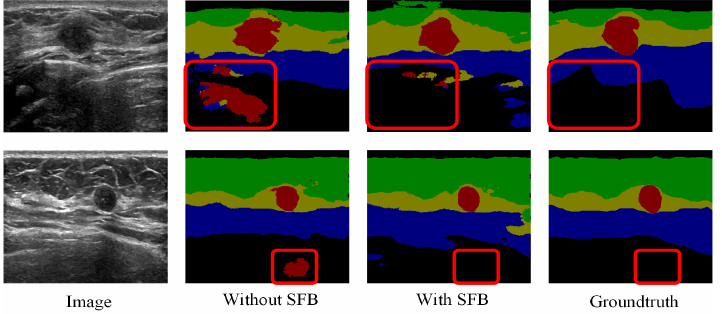
Figure 8. Segmentation results of U-Net with ResNet-101 and CFB on multi-object dataset. Green: fat layer, yellow: mammary layer, blue: muscle layer, red: tumor, and black: background. The red rectangles represent the mis-segmented regions by the baseline module.